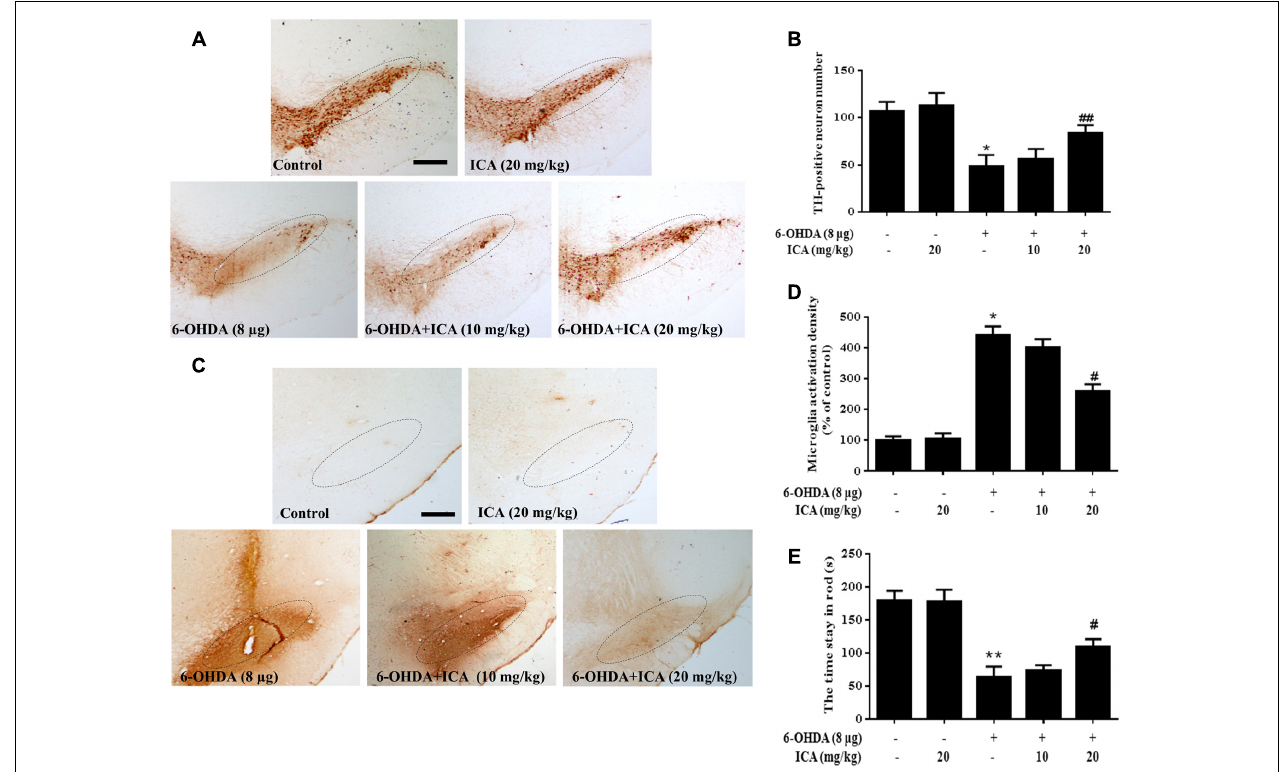
FIGURE 8 | Icariin alleviated 6-OHDA-induced DA neuronal impairment and microglial activation in vivo . After daily intragastric treatment of ICA for 14 consecutive days, rats were sacrificed and the brains sections were immunostained with anti-TH antibody (A) . The number of TH-positive neurons in the SN was counted (B) . Microglia activation in SN was assessed by immunostaining with anti-OX-42 antibody (C) . The densitometry analysis of SN OX-42-positive microglia was analyzed (D) . The “ellipse” presented the area of SN. Scale bar: 200 µ m. In order to verify the effects of 6-OHDA on muscle coordination, the time stayed in rod was tested beginning 10th day after 6-OHDA injection (E) . Results were the mean ± SEM from six rats ( n = 6). ∗ p < 0.05 or ∗∗ p < 0.01 compared with the control group; # p < 0.05 or ## p < 0.01 compared with LPS-treated